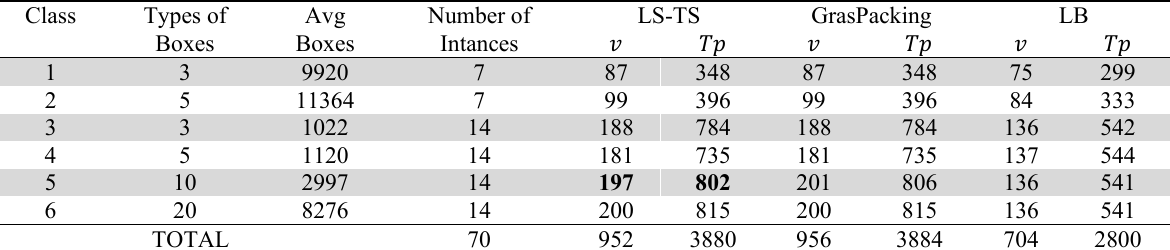
Results of the instances referring to the DPPP. Compared against the LS-TS algorithm of Zachariadis et al. (2012)